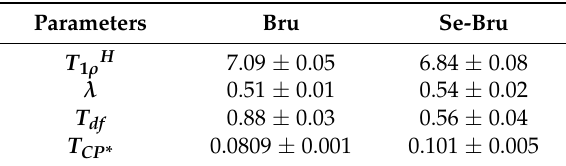
Table 2. 1H → 31P CP MAS NMR kinetics